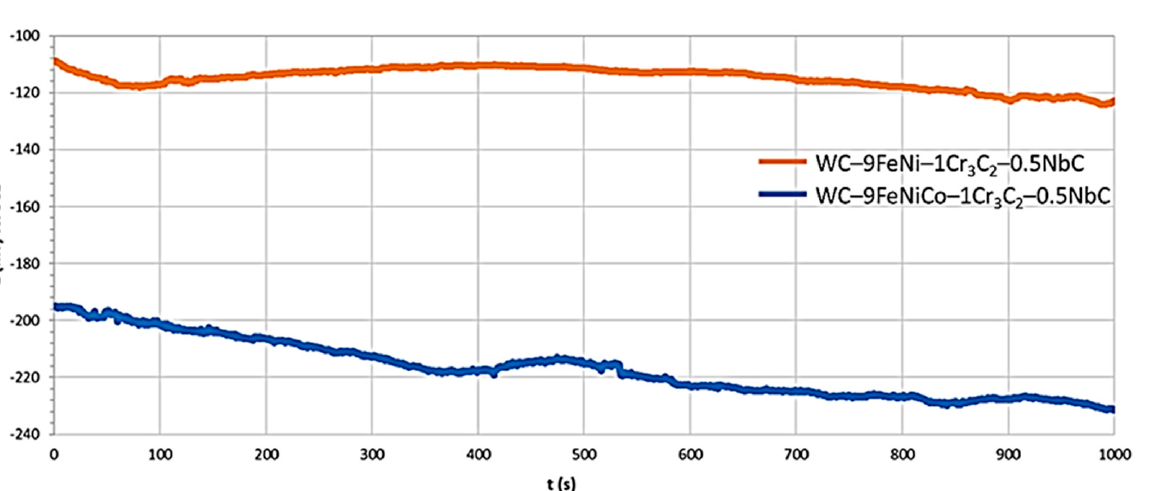
Figure 6. Open circuit potential ( E corr ) versus time curves of samples.